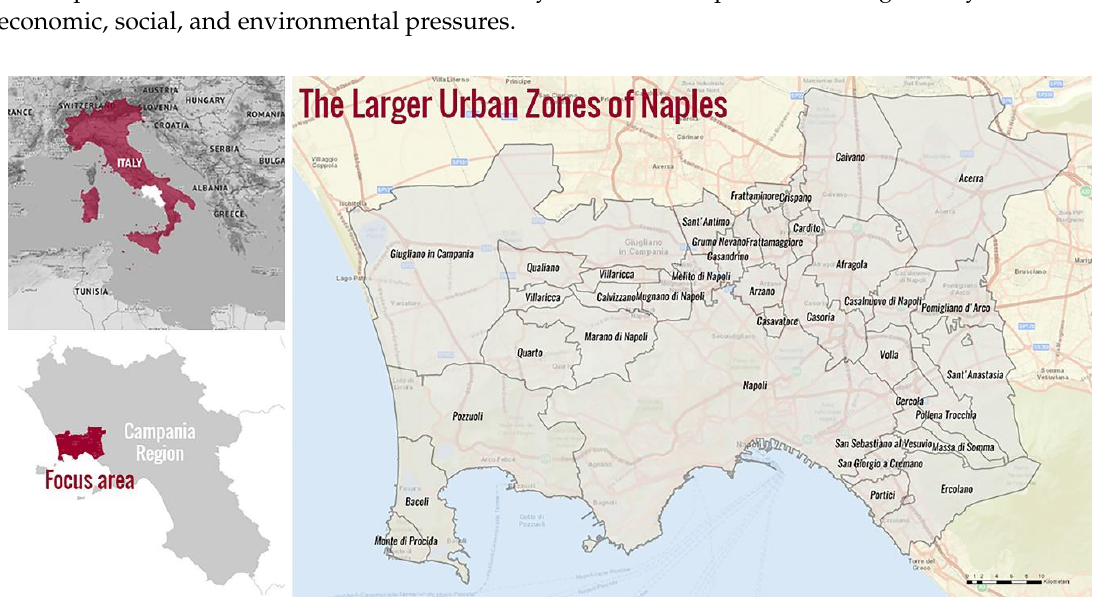
Figure 2. Larger Urban Zones (LUZ) of Naples (Italy): a case study.